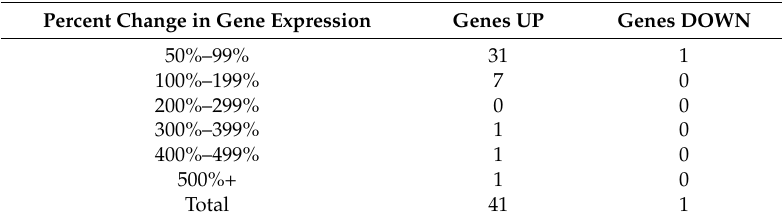
Table 9. Distribution of Genes Affected by GHK and Associated with the Ubiquitin Proteasome System.